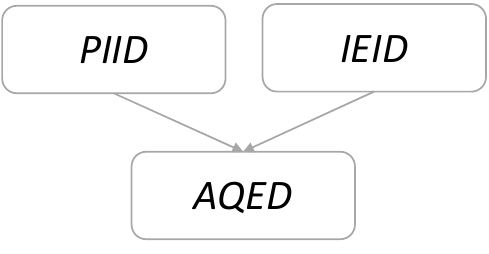
Figure 6. Convergent relationship.